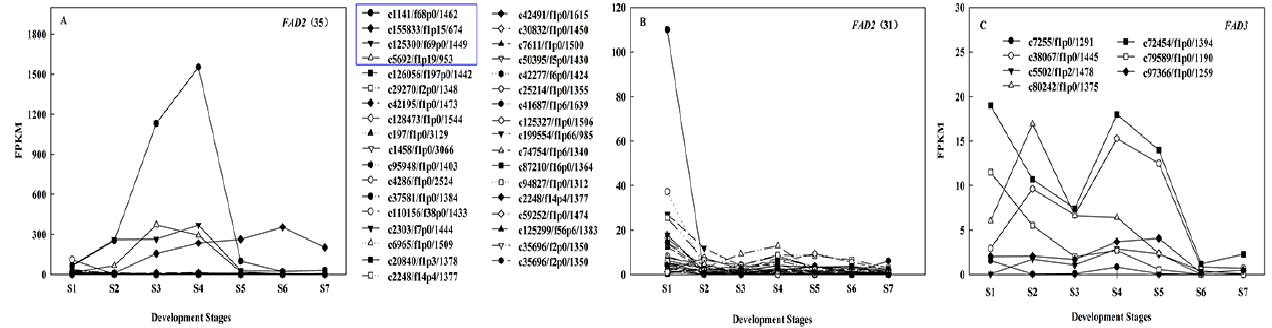
Figure 6. Analysis of gene expression related to FA desaturation pathway in ER. ( A ) Gene expression patterns of thirty-five DEGs encoding FAD2; ( B ) Gene expression patterns of the other thirty-one FAD2s genes, except for four FAD2s with the highest expression levels (blue boxes); ( C ) Gene expression patterns of seven FAD3.